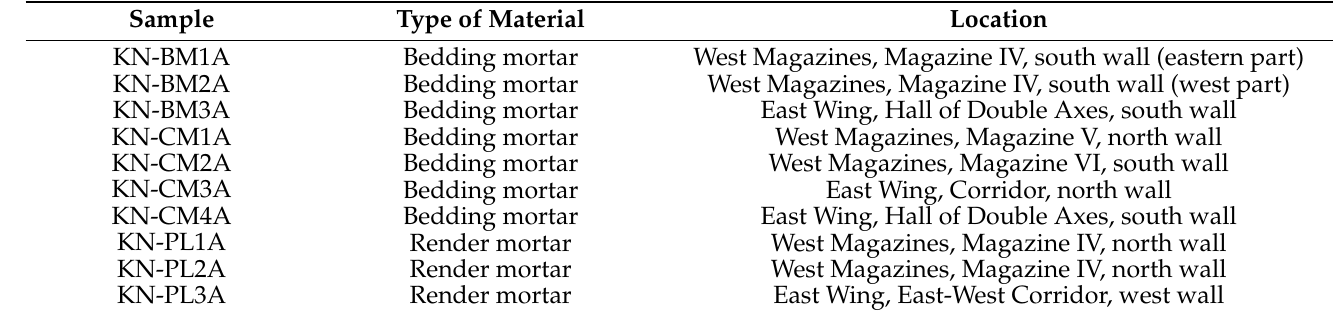
Figure 3. Sampling locations on the Palace of Knossos, West Magazines, and East Wing. (Image adapted from HERACLES Project [3,36]). Table 1. Samples from the Minoan Palace of Knossos.